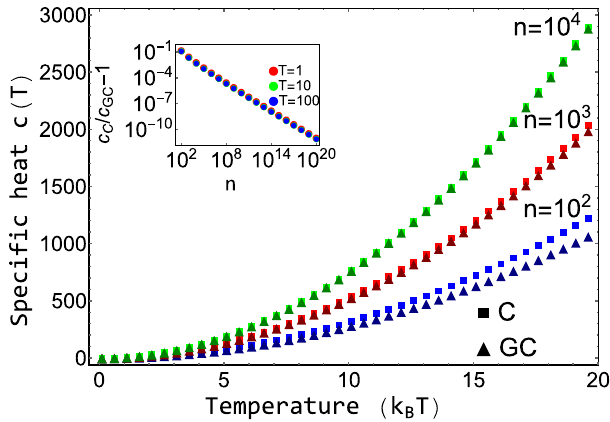
Fig. 1 Speci fi c heat, c ( T ), for the reaction 2 X ⇌ X 2 for the presented canonical approach with an exact number of particles in comparison to the grand-canonical ensemble. The speci fi c heat for the canonical ensemble (C) is drawn by squares, and the speci fi c heat for the grand- canonical ensemble (GC) is drawn by triangles. n denotes the number of particles. For small systems the difference of the approaches becomes apparent. The inset shows the ratio of the speci fi c heat calculated from the exact approach to the one obtained from the grand-canonical ensemble, c c − 1. For large n the quantity decays to zero for any C / GC